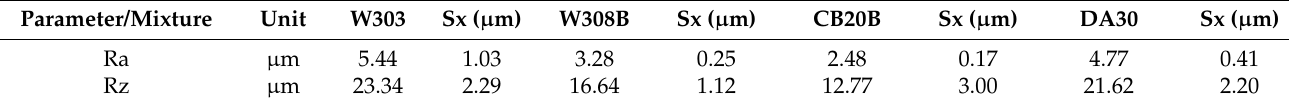
Table 4. Surface roughness of test castings.